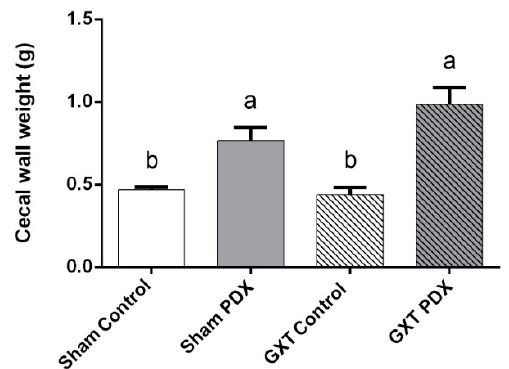
Figure 2. Cecal wall weight (g) of the animals of the experimental groups. Bars with same letters indicate no significant difference according to Tukey’s test ( p < 0.05). Different letters indicate a